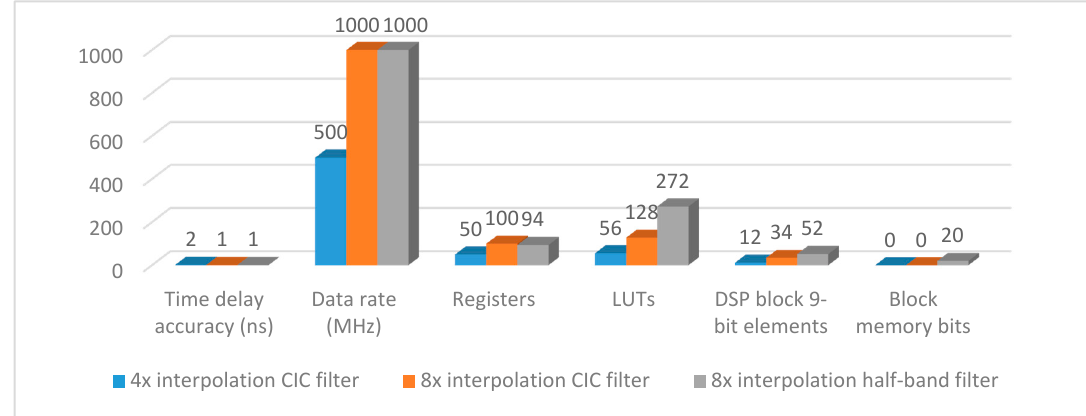
Figure 16. Performances and hardware costs.